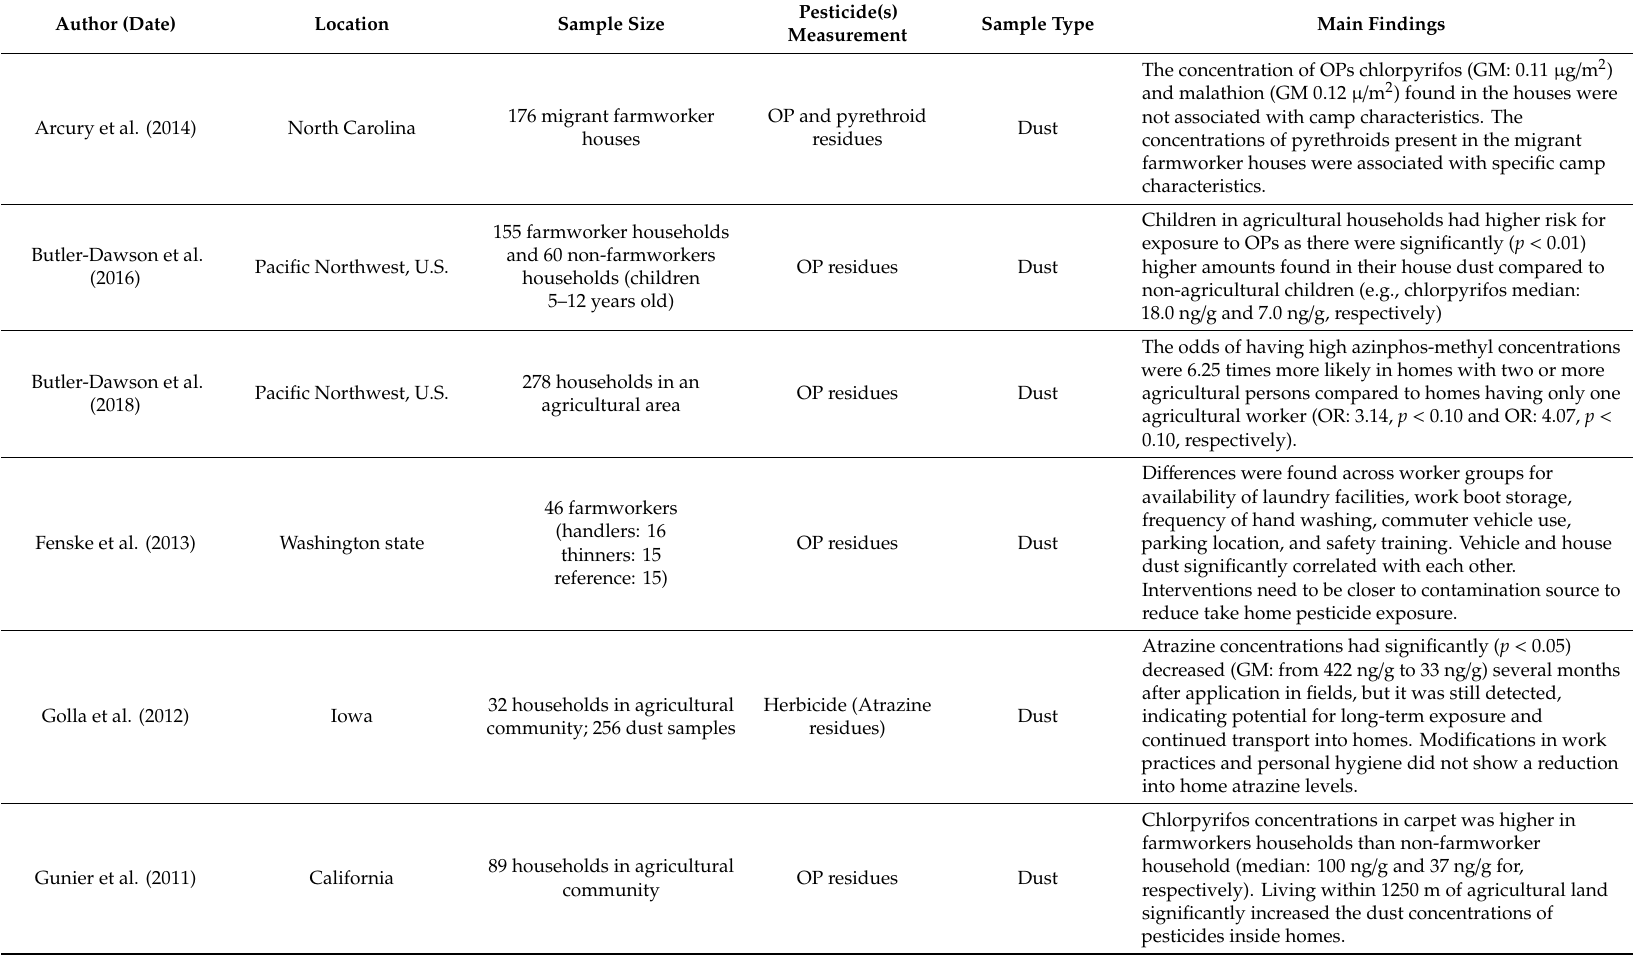
Table 4. Literature review summary on take-home pathway of pesticide exposure—dust and air sample